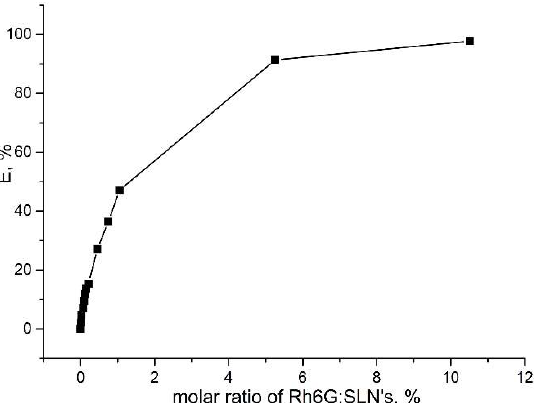
Figure 6. FRET efficiency E vs. molar ratio of Rh6G:SLNs, Rh6G 0.07 μM—0.07mM, SLNs 0.67 mM.